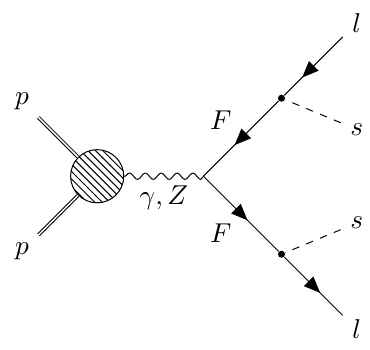
Figure 1 . Diagram for the main production and decay process of F at the LHC, in the leptonic